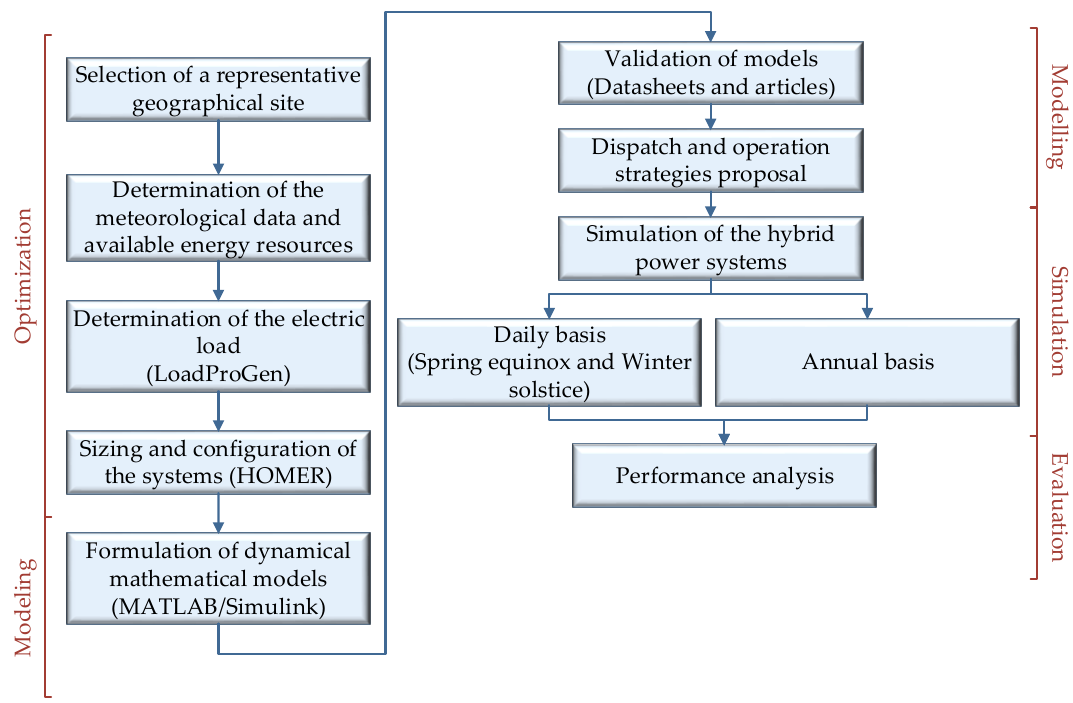
Figure 1. Methodology and general approach of system analysis.